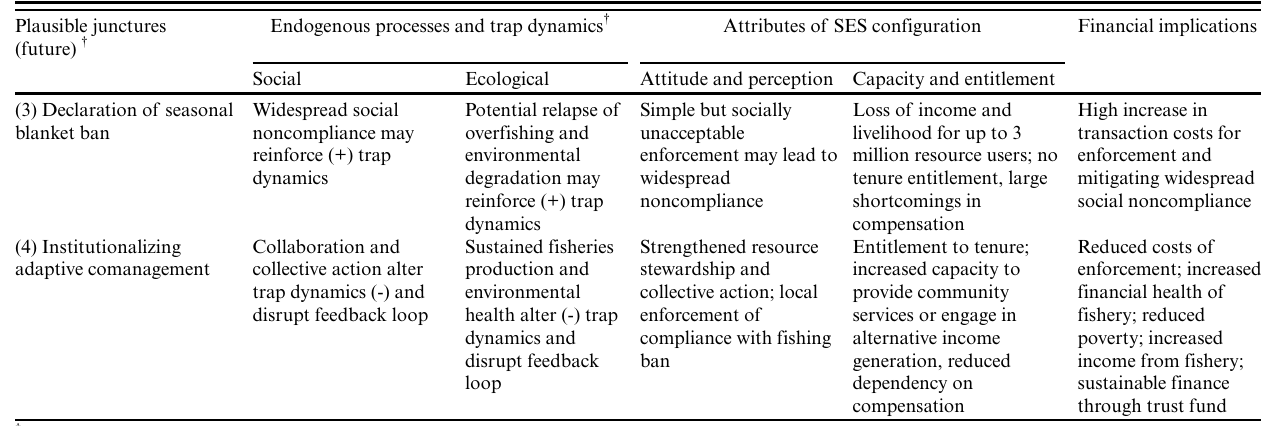
Table 2. Plausible future junctures and endogenous processes (social and ecological) that will influence trap dynamics, perception, and capacity-based attributes of each SES configuration, and its financial implications Plausible junctures (future)